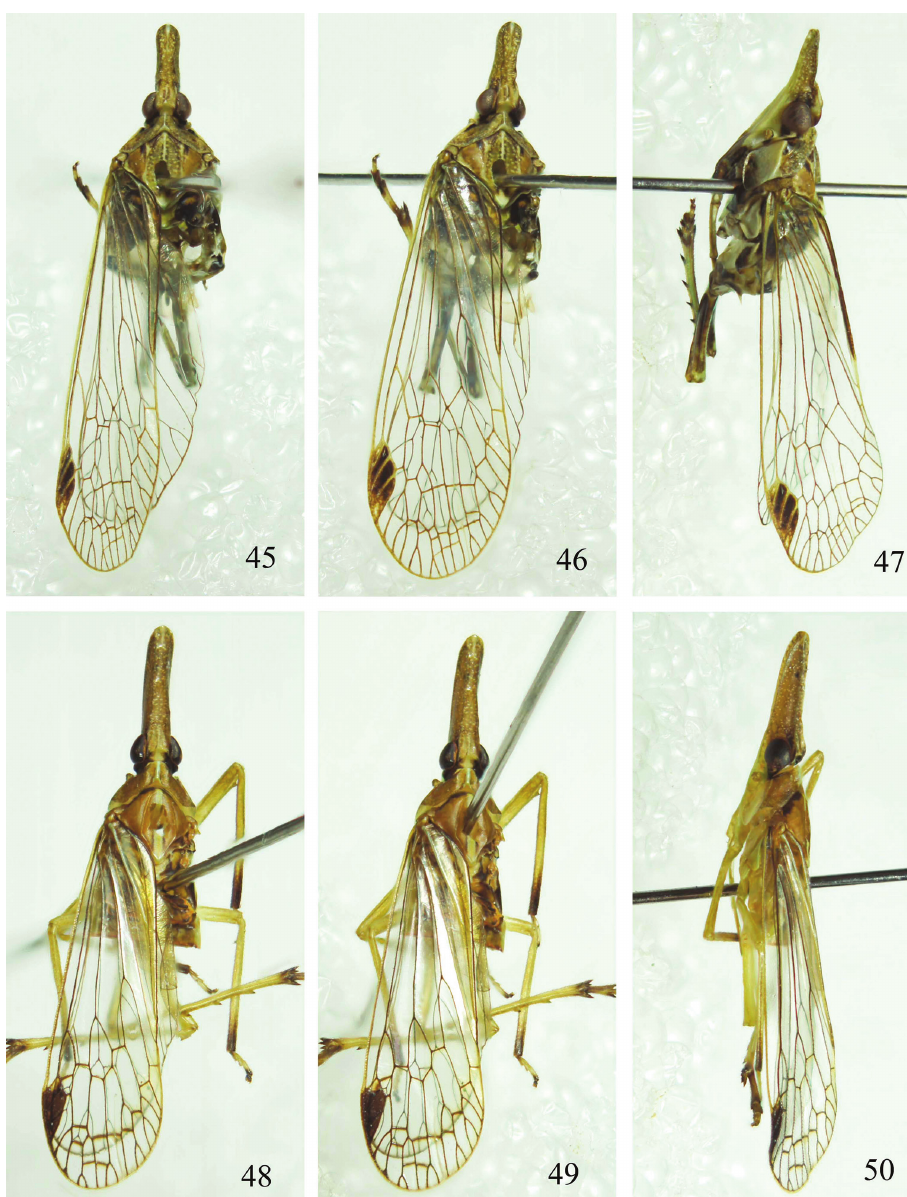
Figures 45–50. Habitus of Saigona species. 45–47 S. anisomorpha Zheng, Yang & Chen, sp. n.; 48–50 S. daozhenensis Zheng, Yang & Chen, sp. n. ( 45, 48 dorsal view; 46, 49 dorsolateral view; 47, 50 lateral